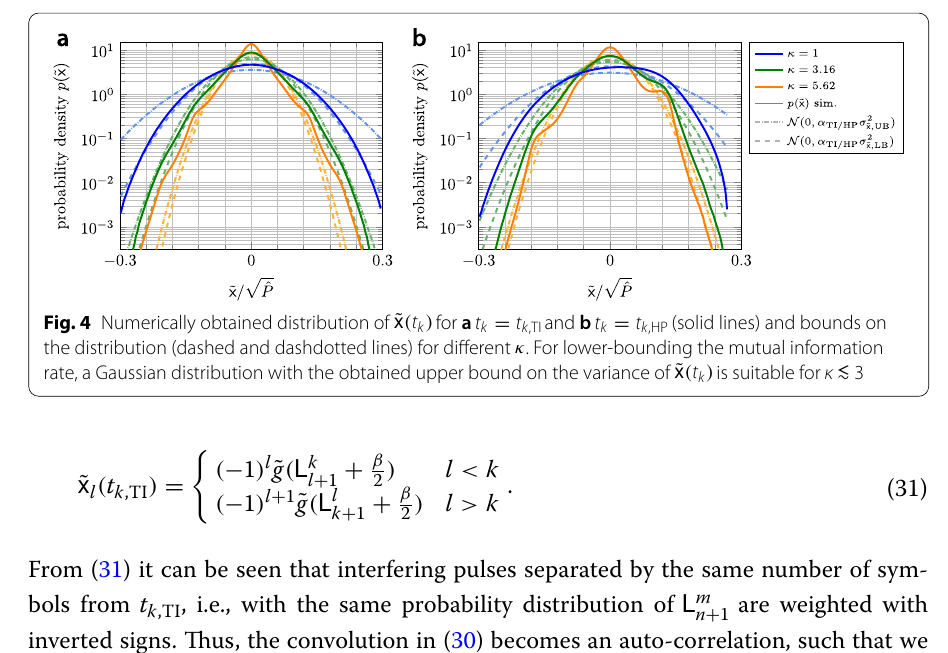
Fig. 4 Numerically obtained distribution of the distribution (dashed and dashdotted lines) for different κ . For lower-bounding the mutual information rate, a Gaussian distribution with the obtained upper bound on the variance of